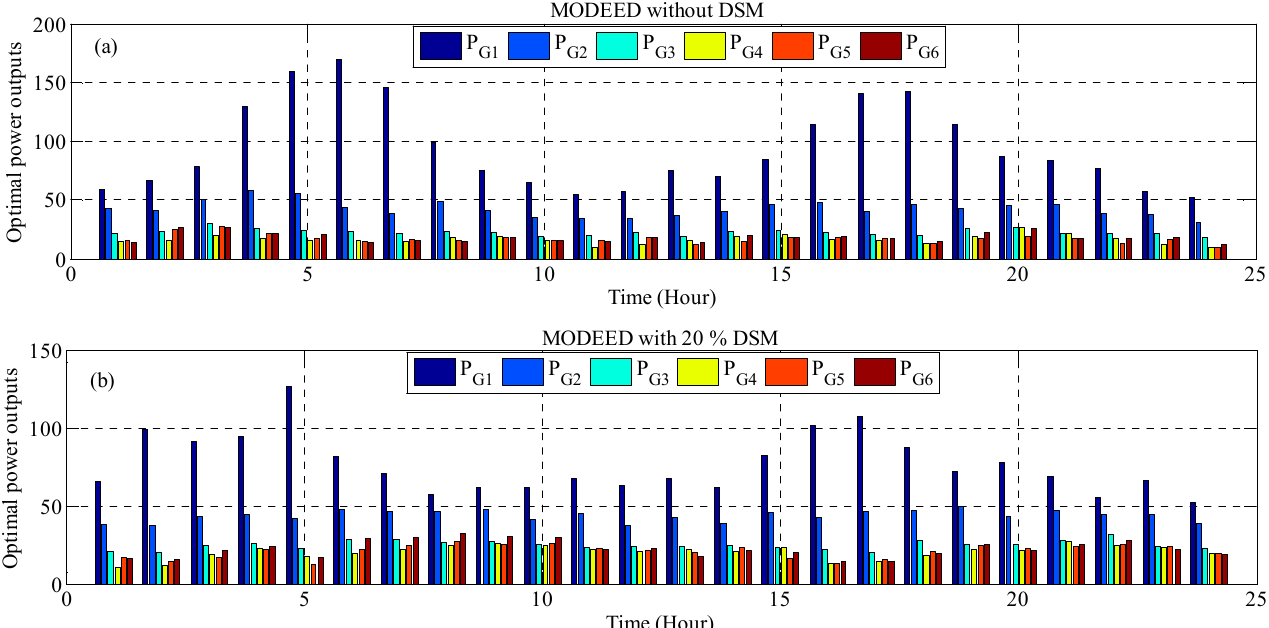
Figure 11. The output of optimized electricity of 24 h of generators, ( a ) in the present of DSM and ( b ) in the absence of DSM.